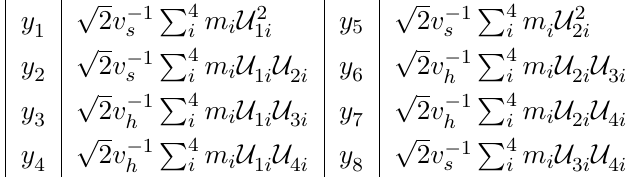
Table 3 . Yukawa couplings in term of physical